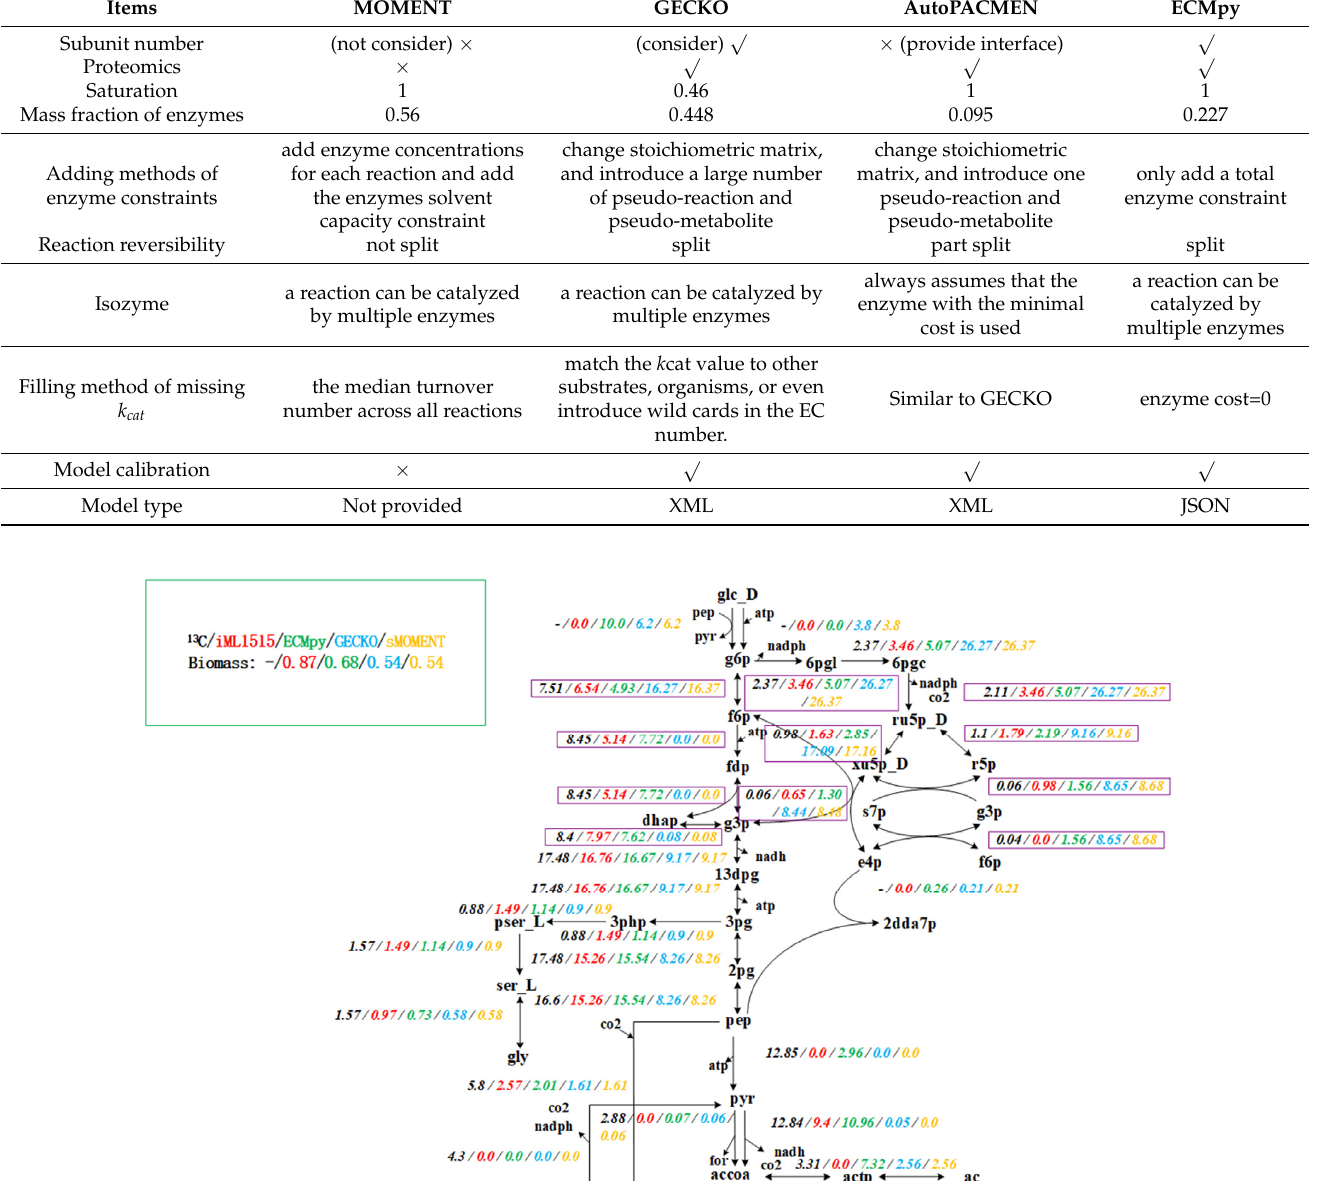
Table 1. Comparison of the Construction Methods of Enzyme-constrained Model.